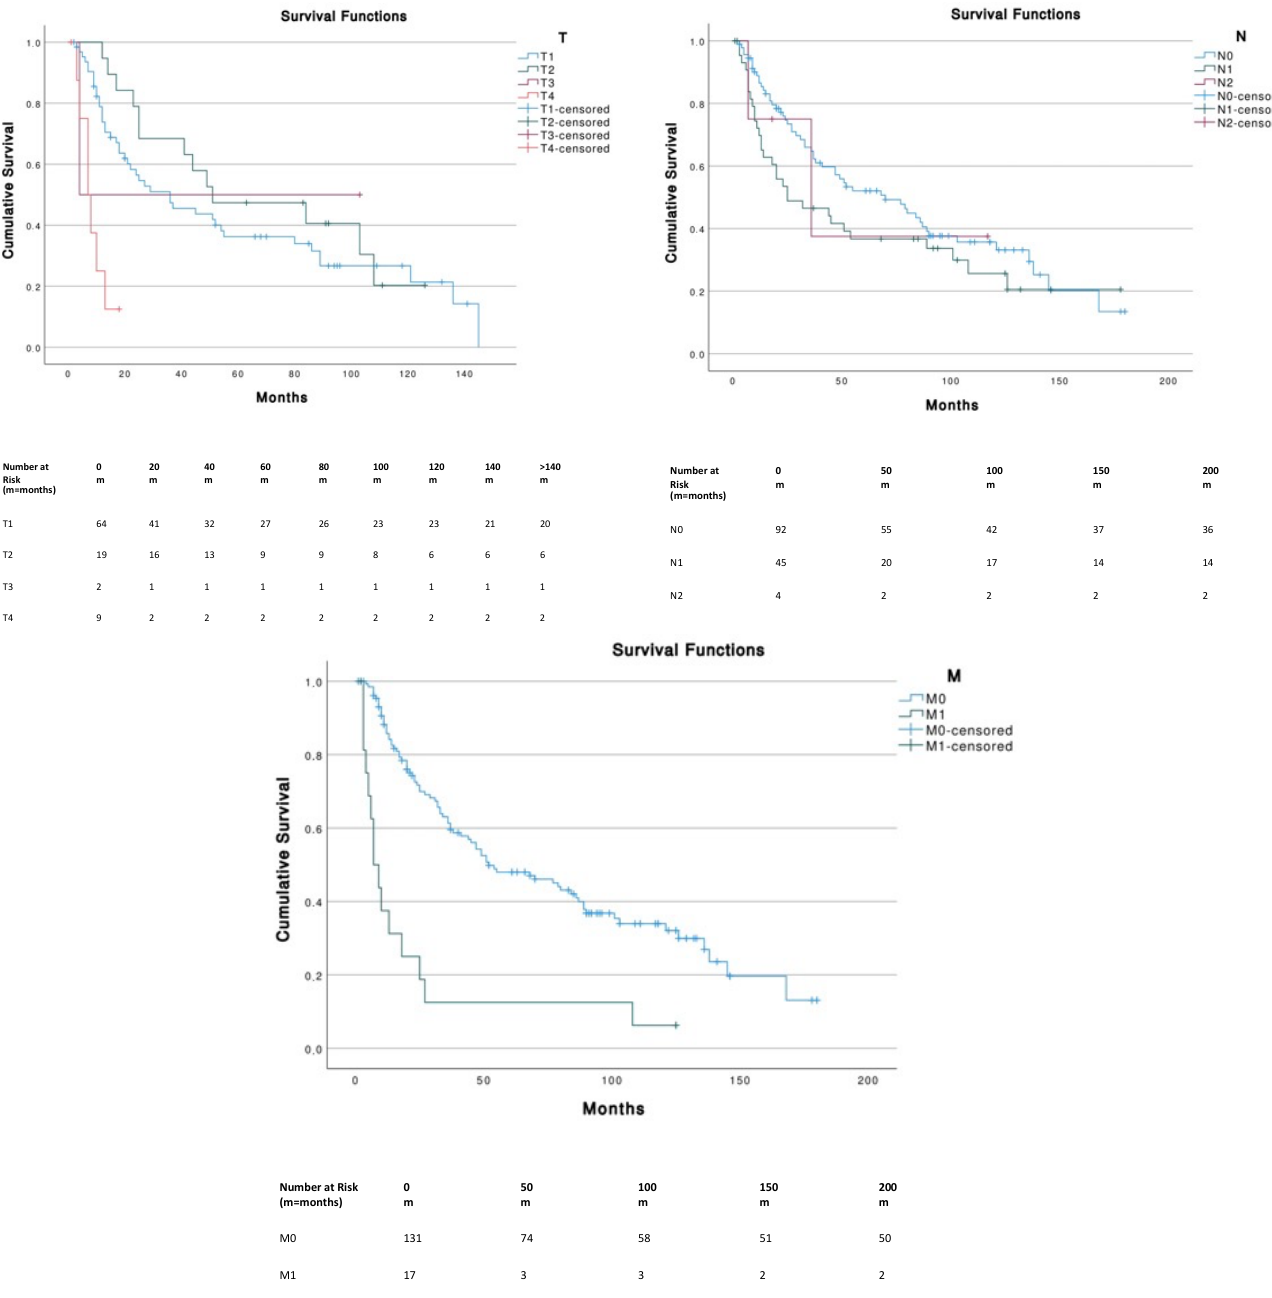
Figure 3. Survival curves according to TNM stages. For Stage I tumors (T1N0M0), wide excision without radiotherapy (Rx) was the best therapeutic strategy among other treatments and was significantly better than local excision with ( p = 0.013) or without Rx ( p = 0.008). Gross excision with Rx was significantly better ( p = 0.047) compared to local excision with Rx (Figure 4). For Stage III tumors (T0-T4, N1-3, M0), no significant differences in survival were found across treatments. Stages II ( n = 11) and IV ( n = 13) were not analyzed because of insufficient data. The use of chem- otherapy (median, 27 months; 95% CI, 4.2–49.7) or the absence of chemotherapy (median, 49 months; 95% CI, 34.2–63.7) was not significantly ( p = 0.586) associated with a better survival.